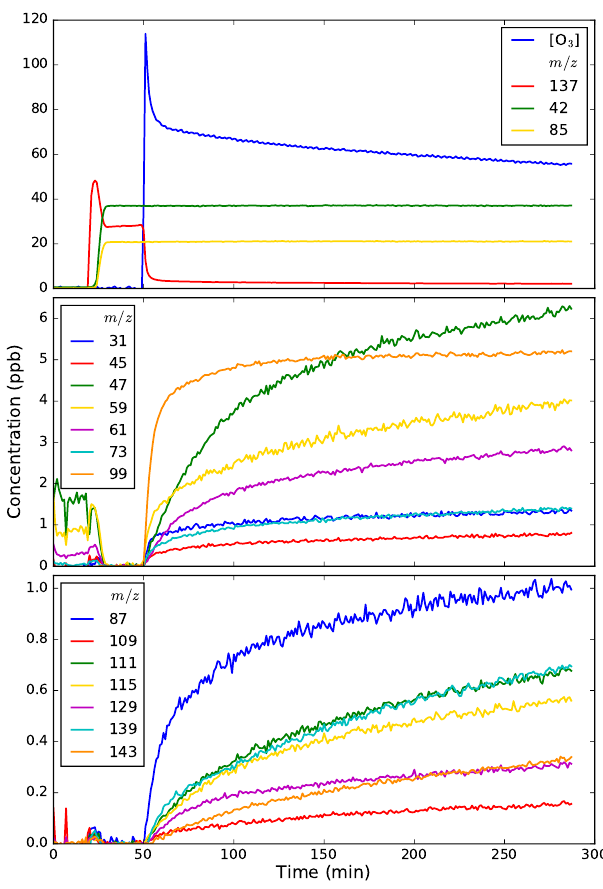
Figure 2. Time profiles of major species detected using the PTR- TOF during the ozonolysis of α -phellandrene in experiment 5. The peak of α -phellandrene observed upon its addition was the result of the reactor fans being switched on immediately prior to the intro- duction of acetonitrile in this